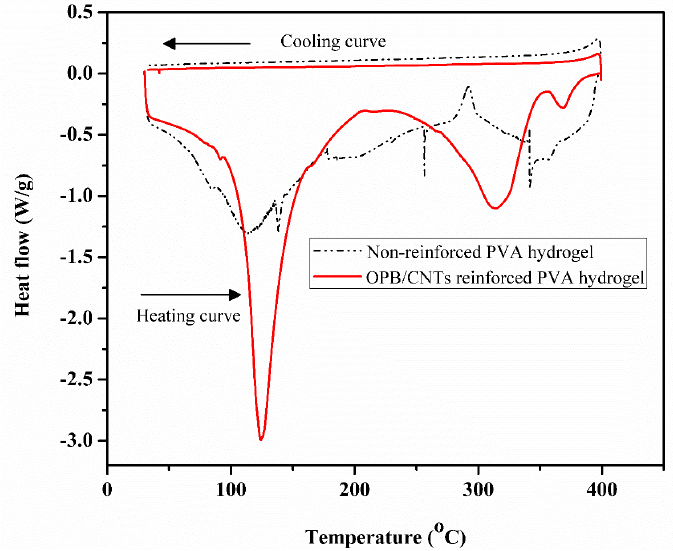
Figure 3. Differential scanning calorimetry (DSC) curves of non-reinforced PVA and OPB/MWCNTs Figure 3. Di ff erential scanning calorimetry (DSC) curves of non-reinforced PVA and OPB / MWCNTs reinforced PVA hydrogels. reinforced PVA hydrogels.